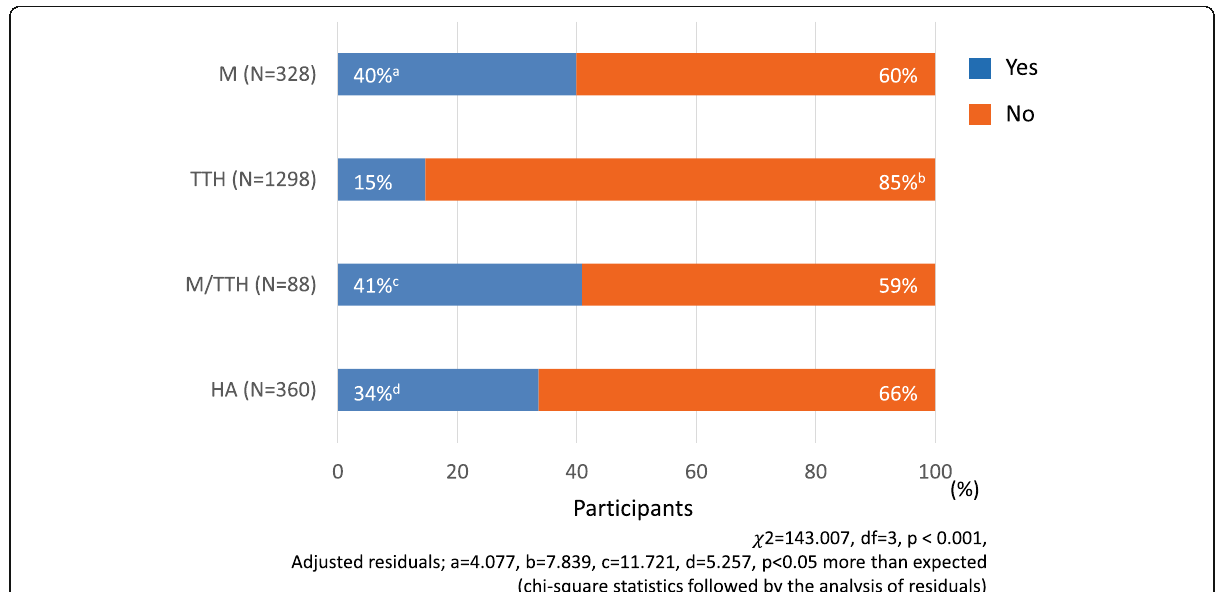
Fig. 1 Symptoms related to headache disorder on days when headaches are not experienced. M, migraine group; TTH, tension-type headache group; M/TTH, a group that satisfies the diagnostic criteria for migraine and tension-type headache; HA, a group that does not meet the diagnostic criteria for migraine or tension-type